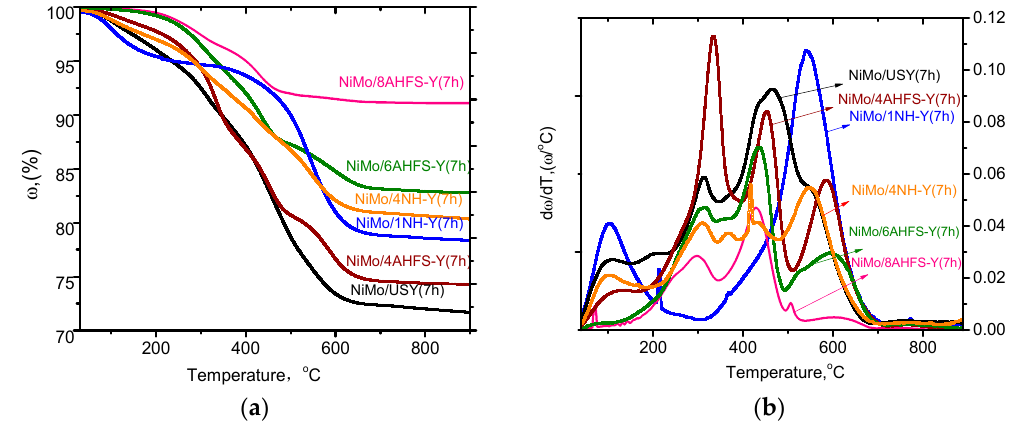
Figure 7. ( a ) TG and ( b ) DTG profiles for used NiMo/USY, NiMo/AHFS-Y, and NiMo/NH-Y catalysts.